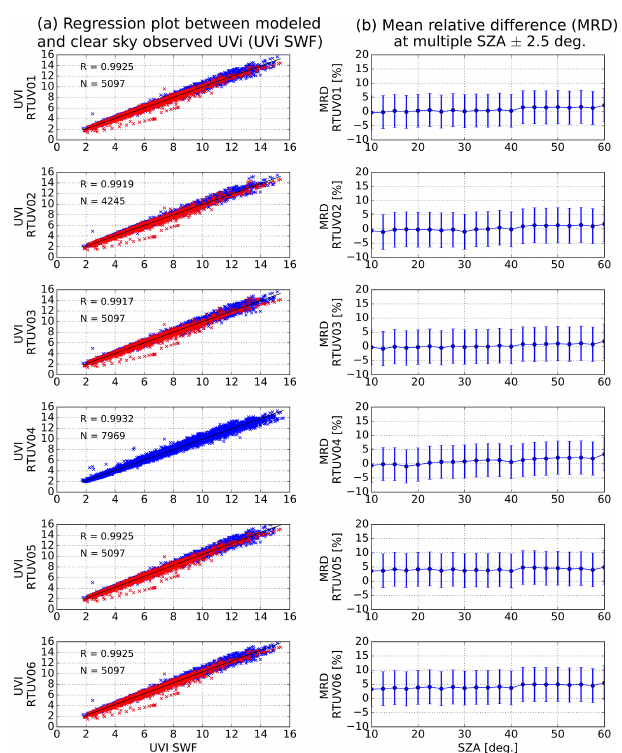
Figure 9. Comparisons of RTUV modelling cases with UVI-SWF observations. (a) UVI RTUV against UVI SWF. Linear regression shown with a black line, all RTUV data against UVI SWF are marked with blue crosses, and RTUV data modelled with an AOT higher than the monthly mean AOT are represented in red. (b) Mean relative difference for a varying SZA with dispersion bar ± 1 σ (standard